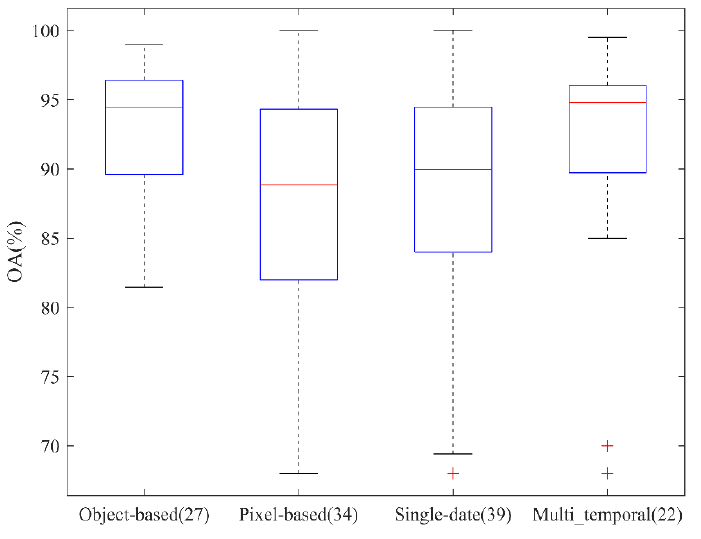
Figure 20. Overall accuracy vs. remote sensing strategies. The red bar shows the median overall accuracy per classification strategy.